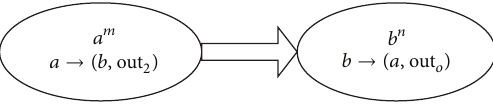
Figure 2: P chain system for